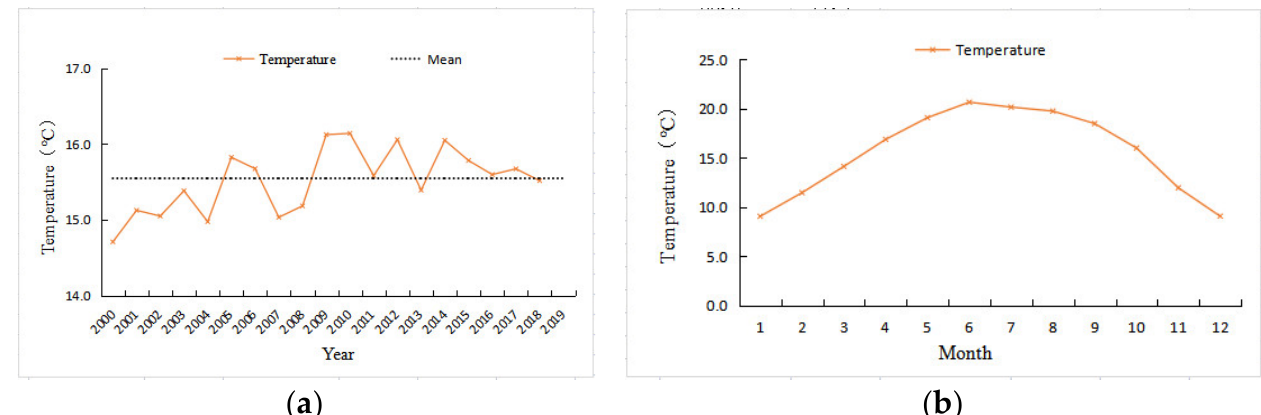
Figure 7. ( a ) Annual and ( b ) monthly temperature in Erhai Lake, from 2000 to 2019.